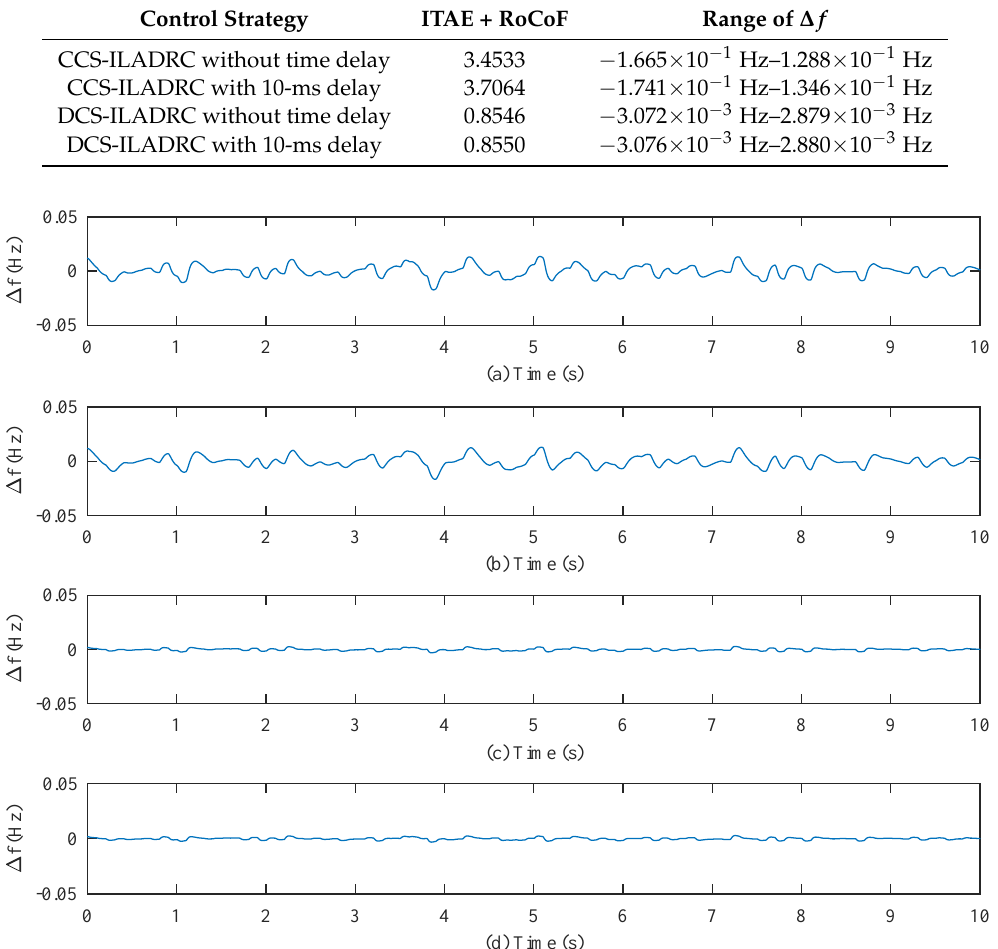
Figure 14. Transient response of system frequency deviation with stochastic disturbance. ( a ) Frequency deviation based on CCS-ILADRC without time delay; ( b ) frequency deviation based on CCS-ILADRC with 10-ms delay; ( c ) frequency deviation based on DCS-ILADRC without time delay; ( d ) frequency deviation based on DCS-ILADRC with 10-ms